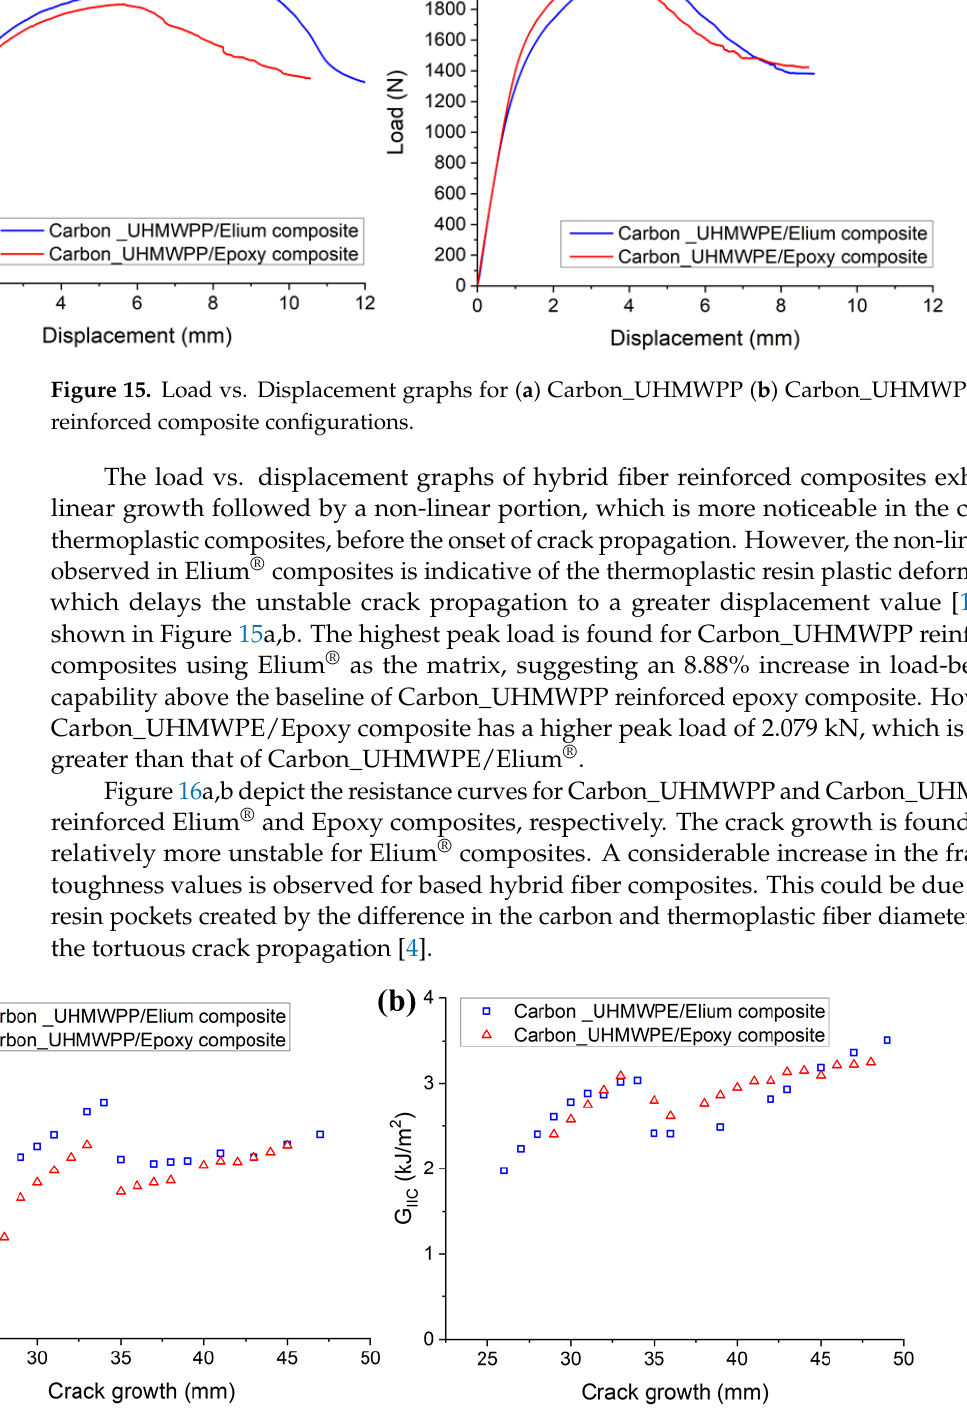
Figure 16 . R-curves for ( a ) Carbon_UHMWPP ( b ) Carbon_UHMWPE composites configurations .